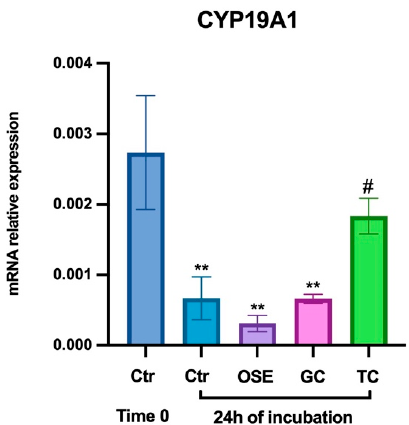
Figure 7. Role of somatic cell coculture on CYP19A1 expression. Three independent FEO maturation protocols were analyzed in the absence (Ctr: hCG alone) or in the presence of primary somatic cell cocultures. Ten follicular walls per group were processed for gene expression analysis. The signi fi cance of mRNA values ( p < 0.05) was statistically analyzed vs. Ctr Time 0 or vs. Ctr 24 h of incubation and indicated with (**) or (#) superscripts for p < 0.05, respectively. In the absence of any cocultures (Ctrl 24 h), hCG alone induced a fourfold downregulation change of CYP19A1 (vs. Ctr time 0; p < 0.01). A signi fi cant downregulation trend was recorded in both FEO cocultured with GC and OSE (4-fold and 8.7-fold, respectively: both vs. Ctr time 0, p < 0.01). On the contrary, any notable reduction was detected in FEO cocultured with TC (1.5-fold change decrease vs. Ctr time 0: p > 0.05). In addition, in the presence of TC, the levels of CYP19A1 transcripts at the end of incubation were signi fi cantly higher than those recorded in the other cultural conditions (vs. Ctr vs. OSE vs. GC: for all p < 0.05) EGF signaling pathway activation was then assessed in FEO with the poorest performances in terms of steroidogenic inhibition (FEO with TC) and FEO with OSE, selected as representative of the ovarian-derived cells type category (Figure 8). When FEO was carried out in the presence of OSE, a marked and signi fi cant activation of EGF cascade was observed at an early time of incubation (1 h), followed by a sharp decrease up to the basal level at 24 h (see Figure 8). Indeed, at 1 h, EGFR and its downstream intracellular MAPK mediators, such as MEK1/2 and ERK1/2, showed respectively 1.8-fold; p < 0.01, 1,4- fold; p < 0.01 and 2.2-fold; p < 0.01. The time-dependent activation of the EGF pathway was not detected when FEO was performed with TC in coculture.